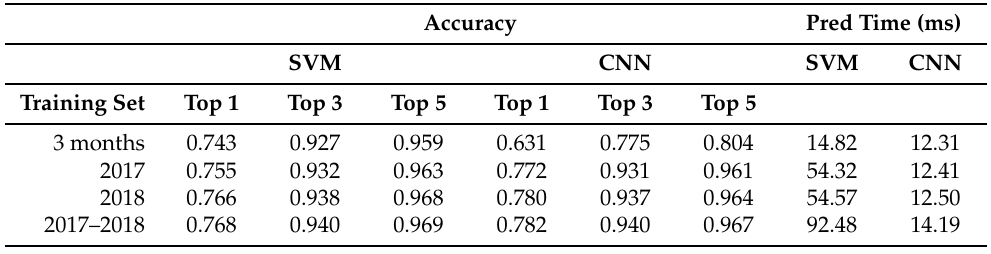
Table 2. Test set balanced accuracy (top 1, top 3 and top 5 most probable clinical pathways) and average prediction time (for 1000 examples) of SVM and CNN models with different training sets. Accuracy Pred Time (ms) SVM CNN SVM CNN Training Set Top 1 Top